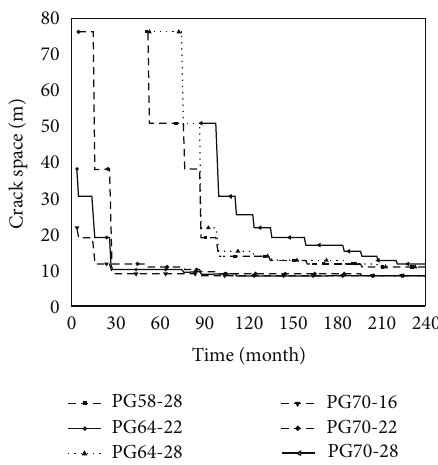
Figure 1: Influence of performance grade of asphalt binder on thermal cracking space on asphalt